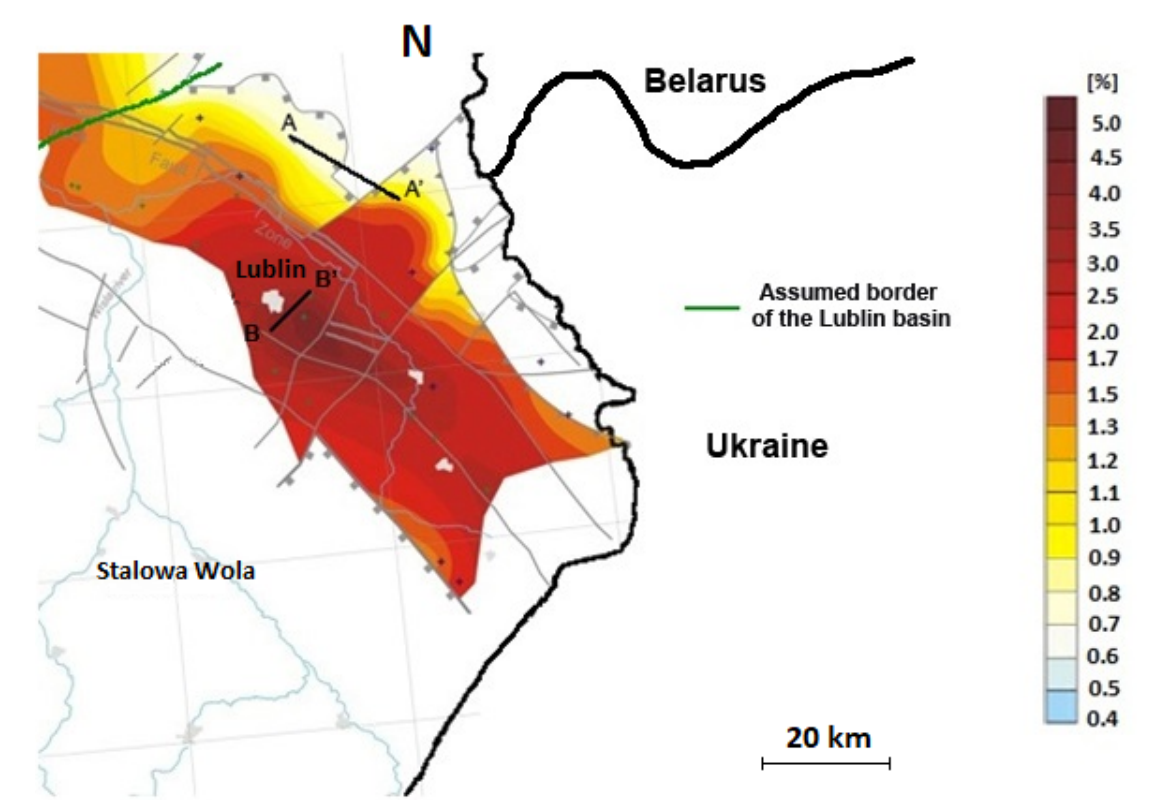
Figure 3. The level of transformation of the organic matter in Lublin Basin (based on [20]).